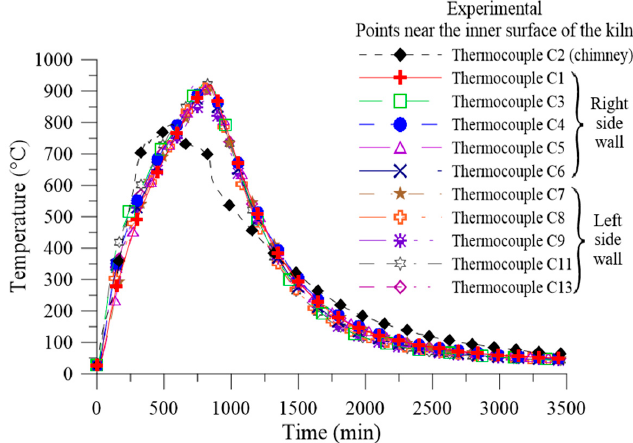
Figure 6. Outer surface temperature of the kiln and air as a function of time.